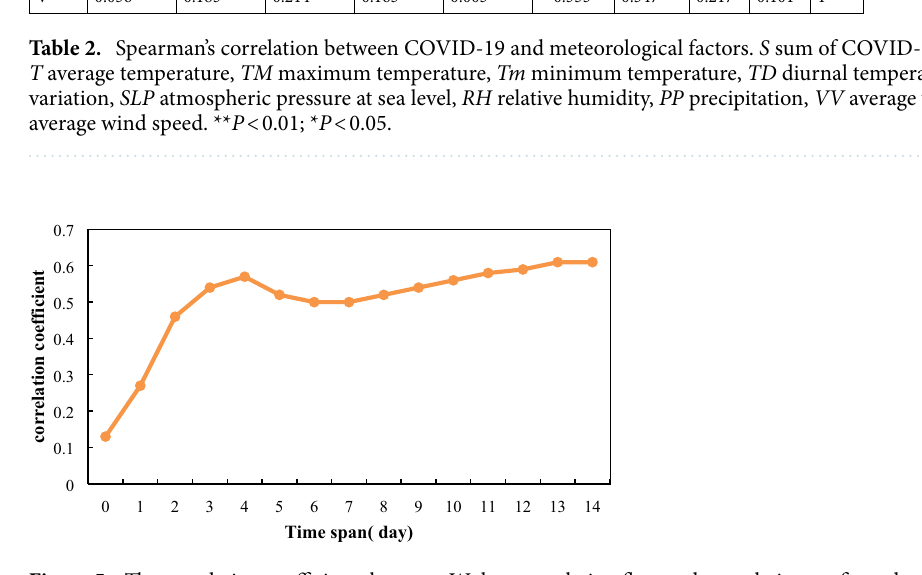
from January 10 to February 6 (January 23 plus 14 days), with the interval of 0–14 days. As can be seen in Fig. 5, as the time span increased, higher correlation coefficients were observed and the correlation reached the first peak when we considered an interval of 4 days. From our results, it can be inferred that the effective time span for considering the influence of Wuhan Population flow on epidemic is 4 days. This is more detailed than those studies that have claimed the interval of 3–7 days for taking into account the influence of population flow 1,21,48 .